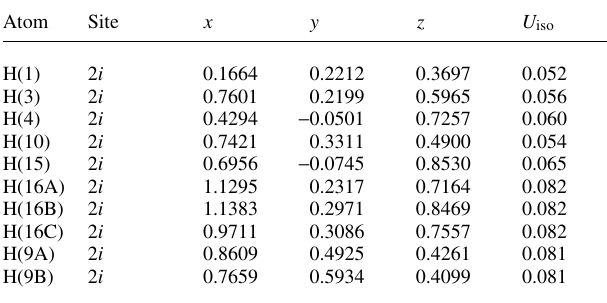
Table 2. Atomic coordinates and displacement parameters (in Å 2 )